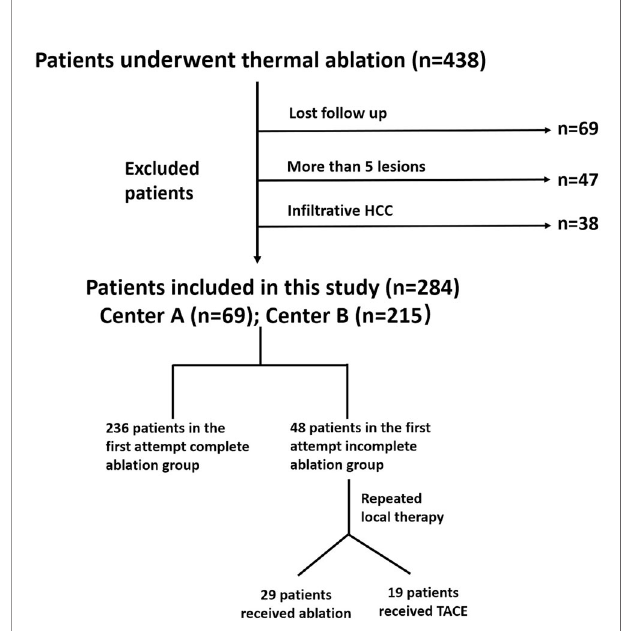
FIGURE 1 | Flowchart of the study